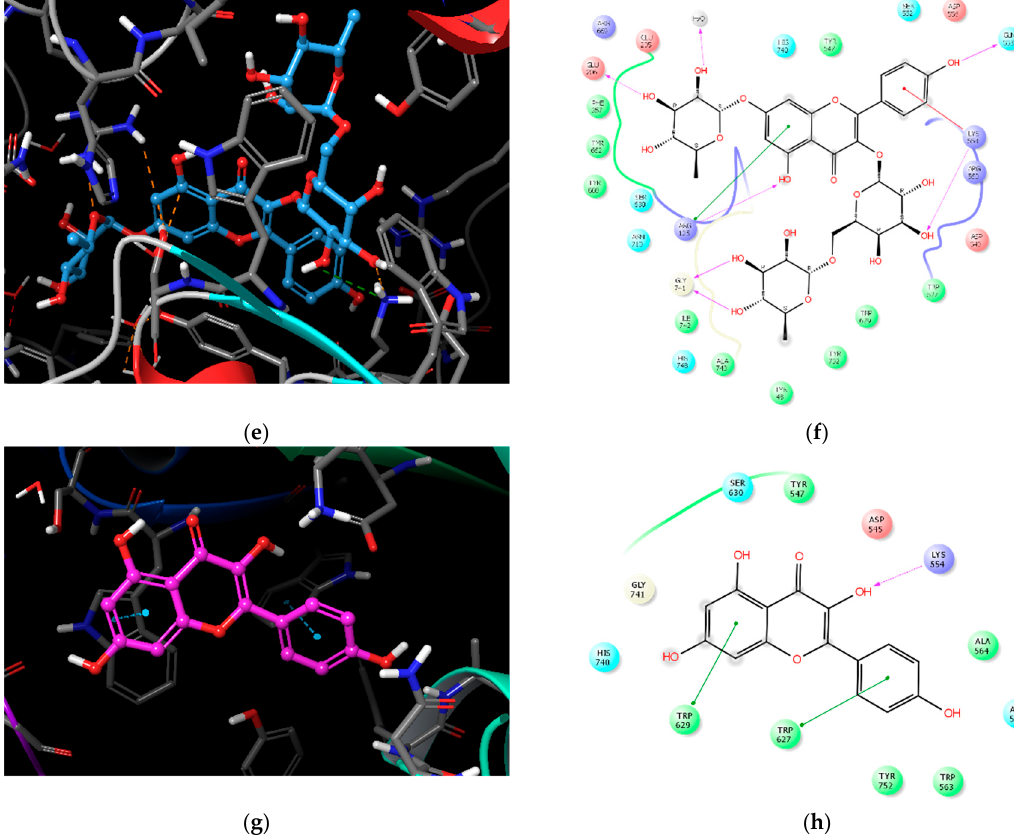
Figure 4. Docking poses of compounds 1 – 4 in the dipeptidyl peptidase IV active site and their ligand interaction diagrams (LIDs). ( a ) Docking pose of compound 1 , ( b ) LID of compound 1 , ( c ) docking pose of compound 2 , ( d ) LID of compound 2 , ( e ) docking pose of compound 3 , ( f ) LID of compound 3 , ( g ) docking pose of compound 4 , and ( h ) LID of compound 4 . All interacting residues and water molecules are shown in the atom-colored stick model. All compounds are represented in the ball-and-stick model. Orange dotted lines indicate hydrogen bonds, and blue dotted lines denote π – π interactions. Only polar hydrogens in compounds are shown for clarity. In the LIDs, solid magenta arrows indicate hydrogen bonds with backbones, dashed magenta arrows indicate hydrogen bonds with side chains, green lines indicate π – π stacking, and red lines represent π –cation stacking. Residues are colored in circles according to their properties: (1) orange for negatively charged compounds, (2) purple for positively charged compounds, (3) green for hydrophobic compounds, (4) blue for polar compounds, (5) ivory for glycines, and (6) grey for water molecules. Compound 2 , which possesses four sugar moieties, had the second strongest inhibitory activity.